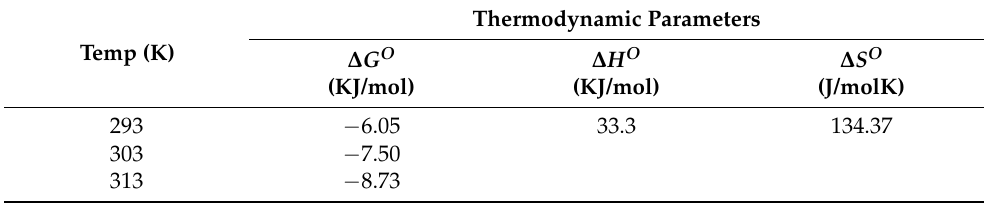
Table 4. Thermodynamic parameters for MB dye adsorption on HA/Au nanocomposite surface.